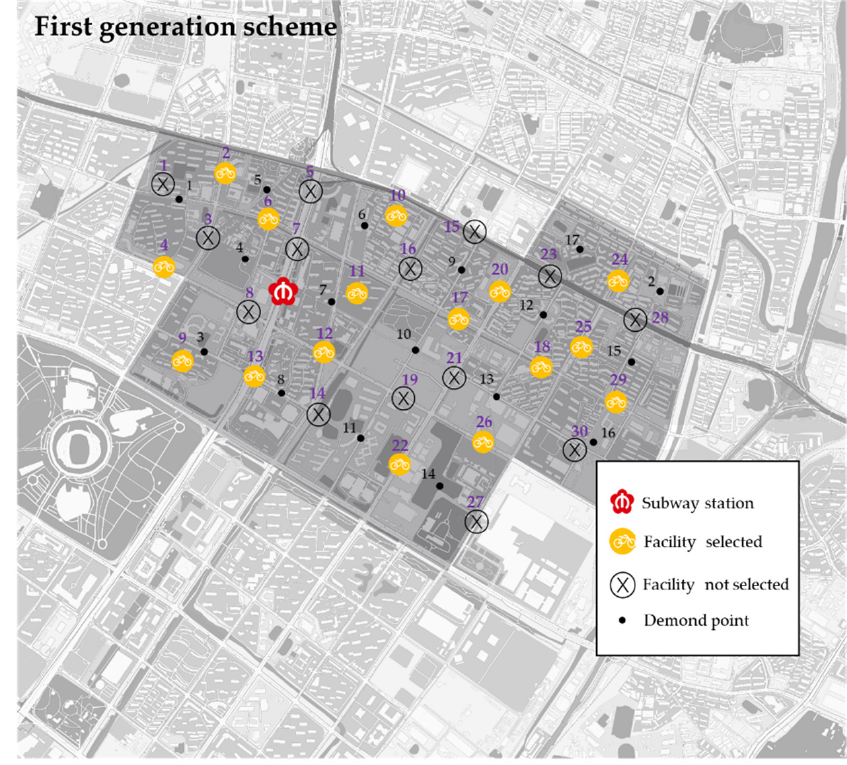
Figure 6. The first- generation layout scheme of bike-sharing facilities.